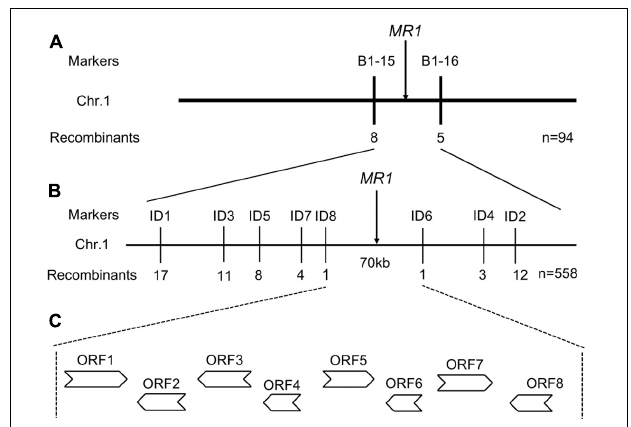
FIGURE 5 | Fine mapping of the MR1 gene. (A) Genetic linkage map for the primary location of the MR1 gene using 94 F 2 recessive plants. (B) Fine physical map of the MR1 gene using 558 F 2 recessive plants. (C) ORFs in the target region. ORFs indicate open reading frames.